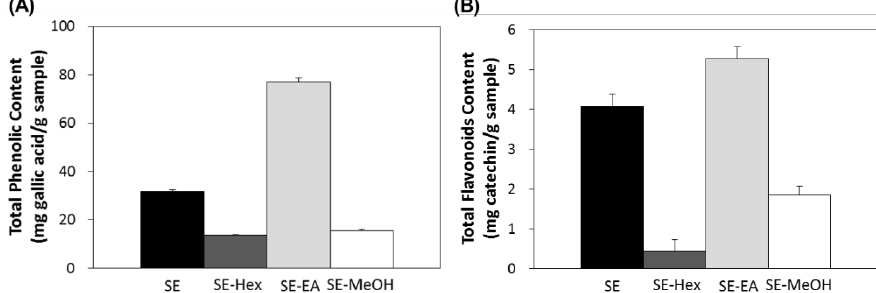
Figure 1. Total polyphenols content ( A ) and total flavonoids content ( B ) of S. orientalis extracts.